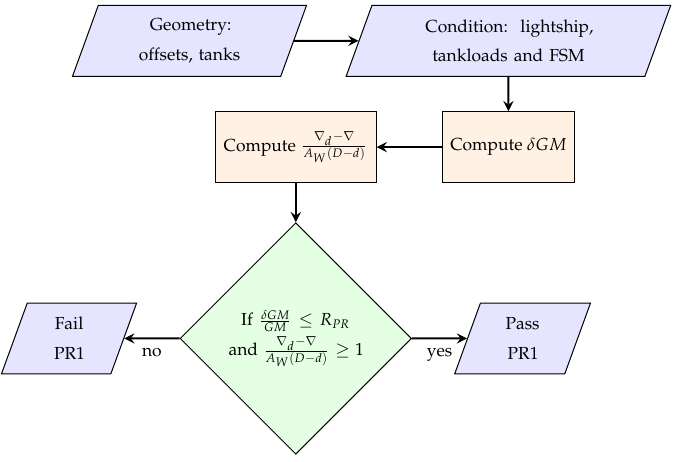
Figure 12. Parametric Roll Level 1 algorithm process